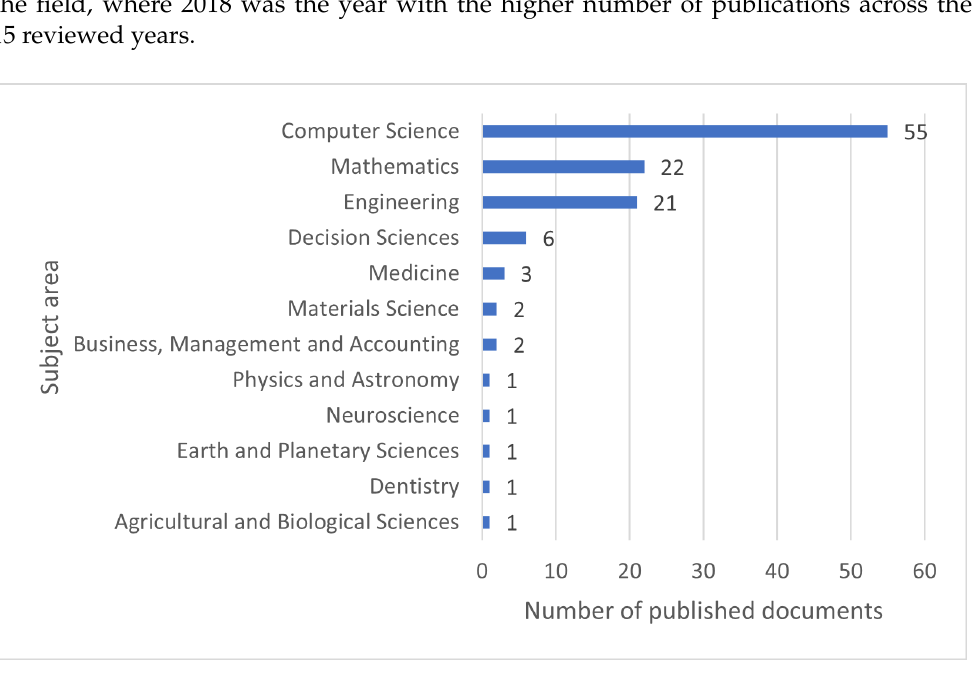
Figure 1. Number of published documents by subject